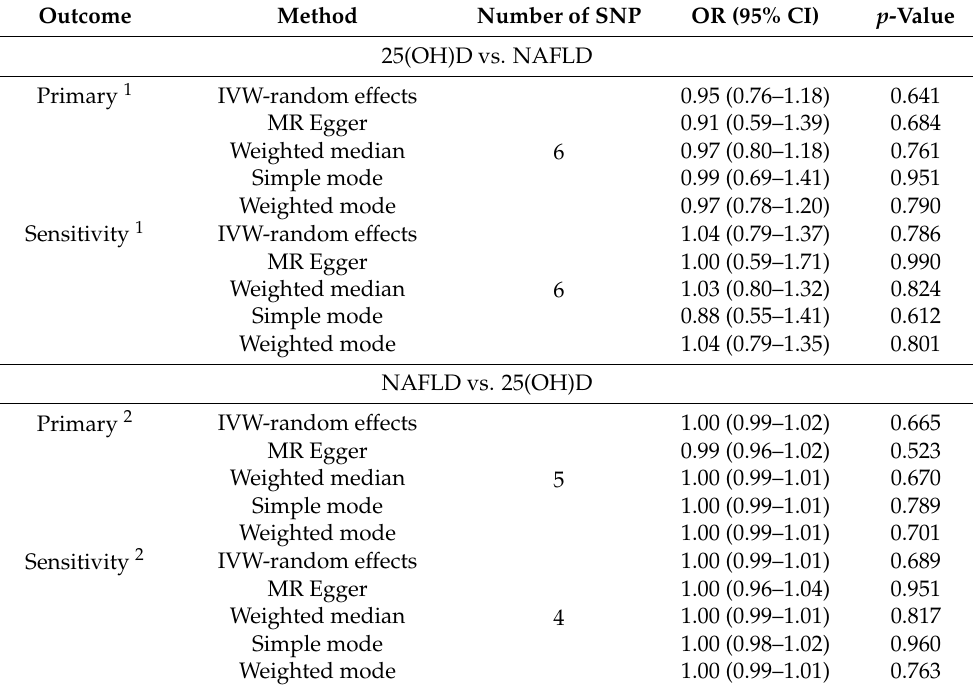
Table 1. Results of two-sample bidirectional MR analysis of the causal effects between 25(OH)D serum levels and